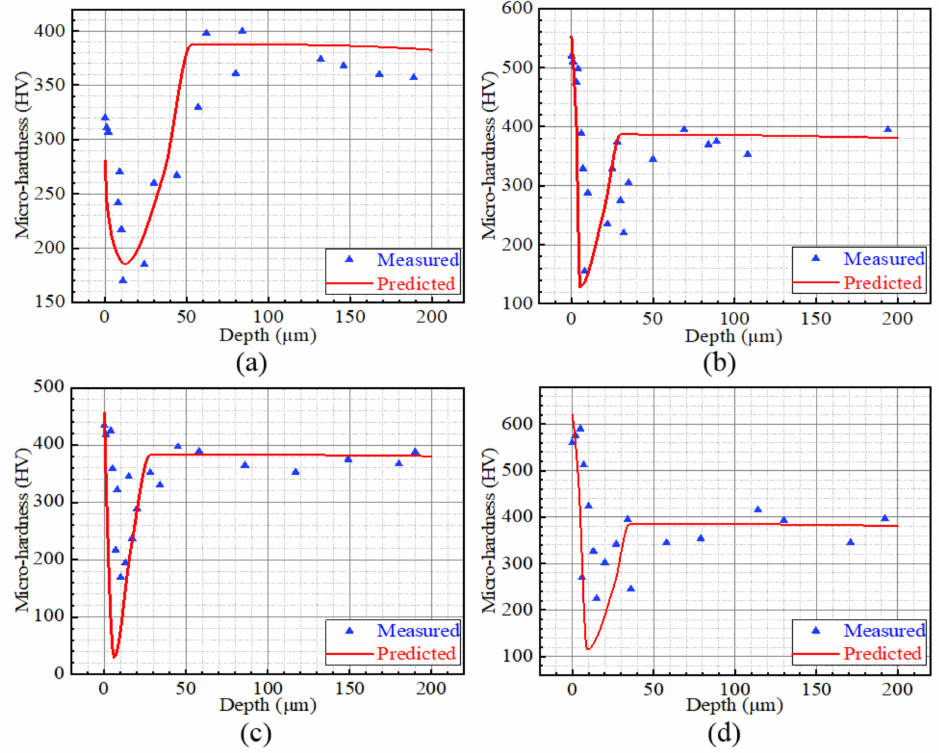
Figure 13. Evaluated and measured microhardness profiles: ( a ) Case 1, ( b ) Case 2, ( c ) Case 7, ( d ) Case